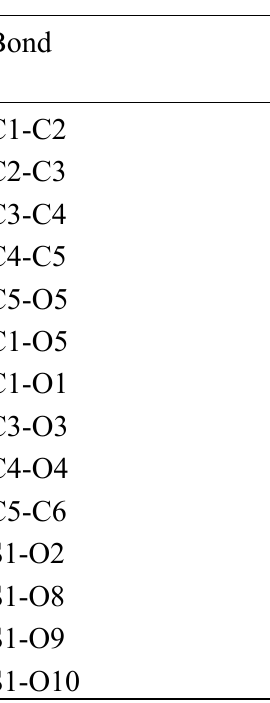
Table 4. Selected optimized and experimental bond lengths for IdoA2-SO